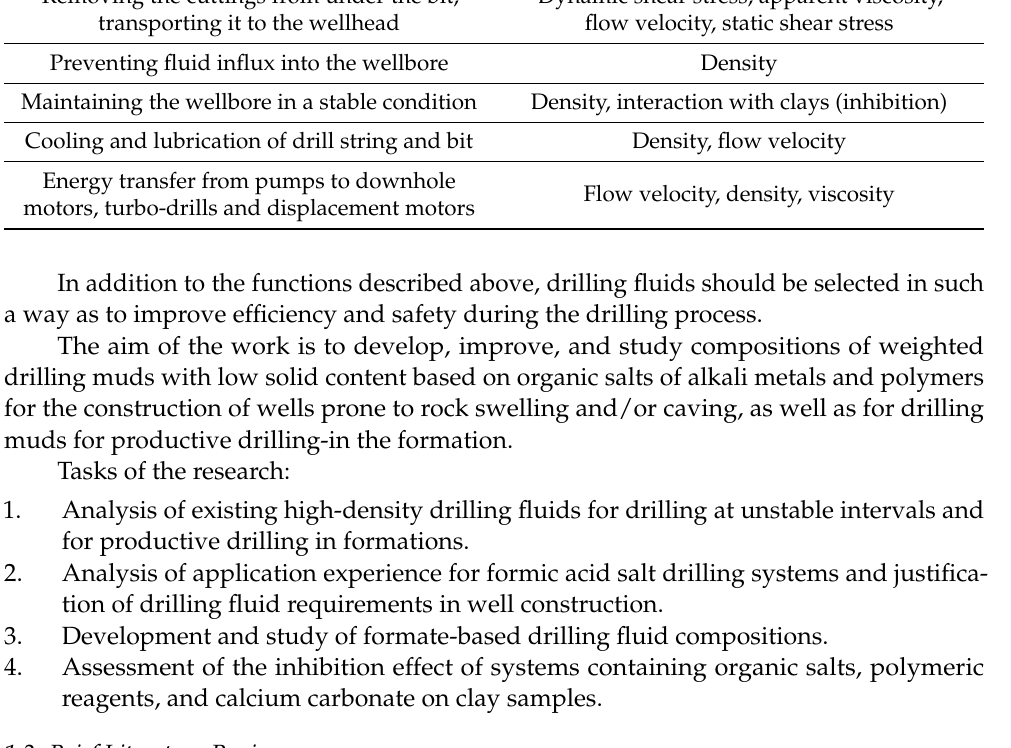
Table 1. Functions and corresponding properties of drilling fluids. Function of Drilling Fluid Corresponding Property of Drilling Fluid Removing the cuttings from under the bit, Dynamic shear stress, apparent viscosity, transporting it to the wellhead flow velocity, static shear stress Preventing fluid influx into the wellbore Density Maintaining the wellbore in a stable condition Density, interaction with clays (inhibition) Cooling and lubrication of drill string and bit Density, flow velocity Energy transfer from pumps to downhole Flow velocity, density, motors, turbo-drills and displacement motors